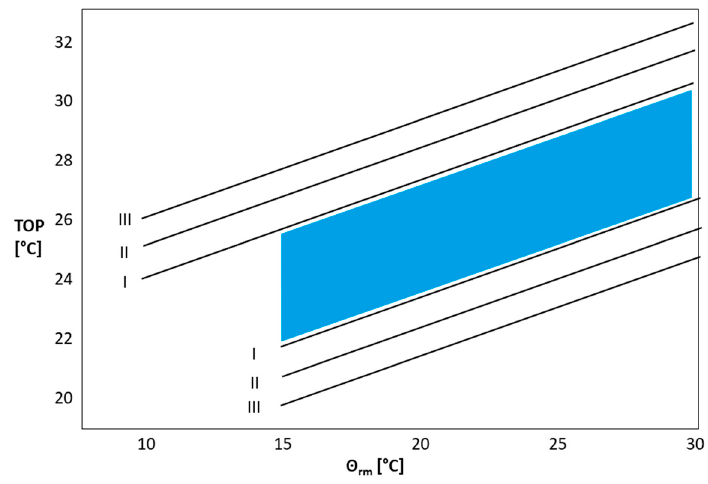
Figure 3. Energy saving potential within the adaptive thermal comfort band (own representation based on DIN EN 16798-1 [22]).